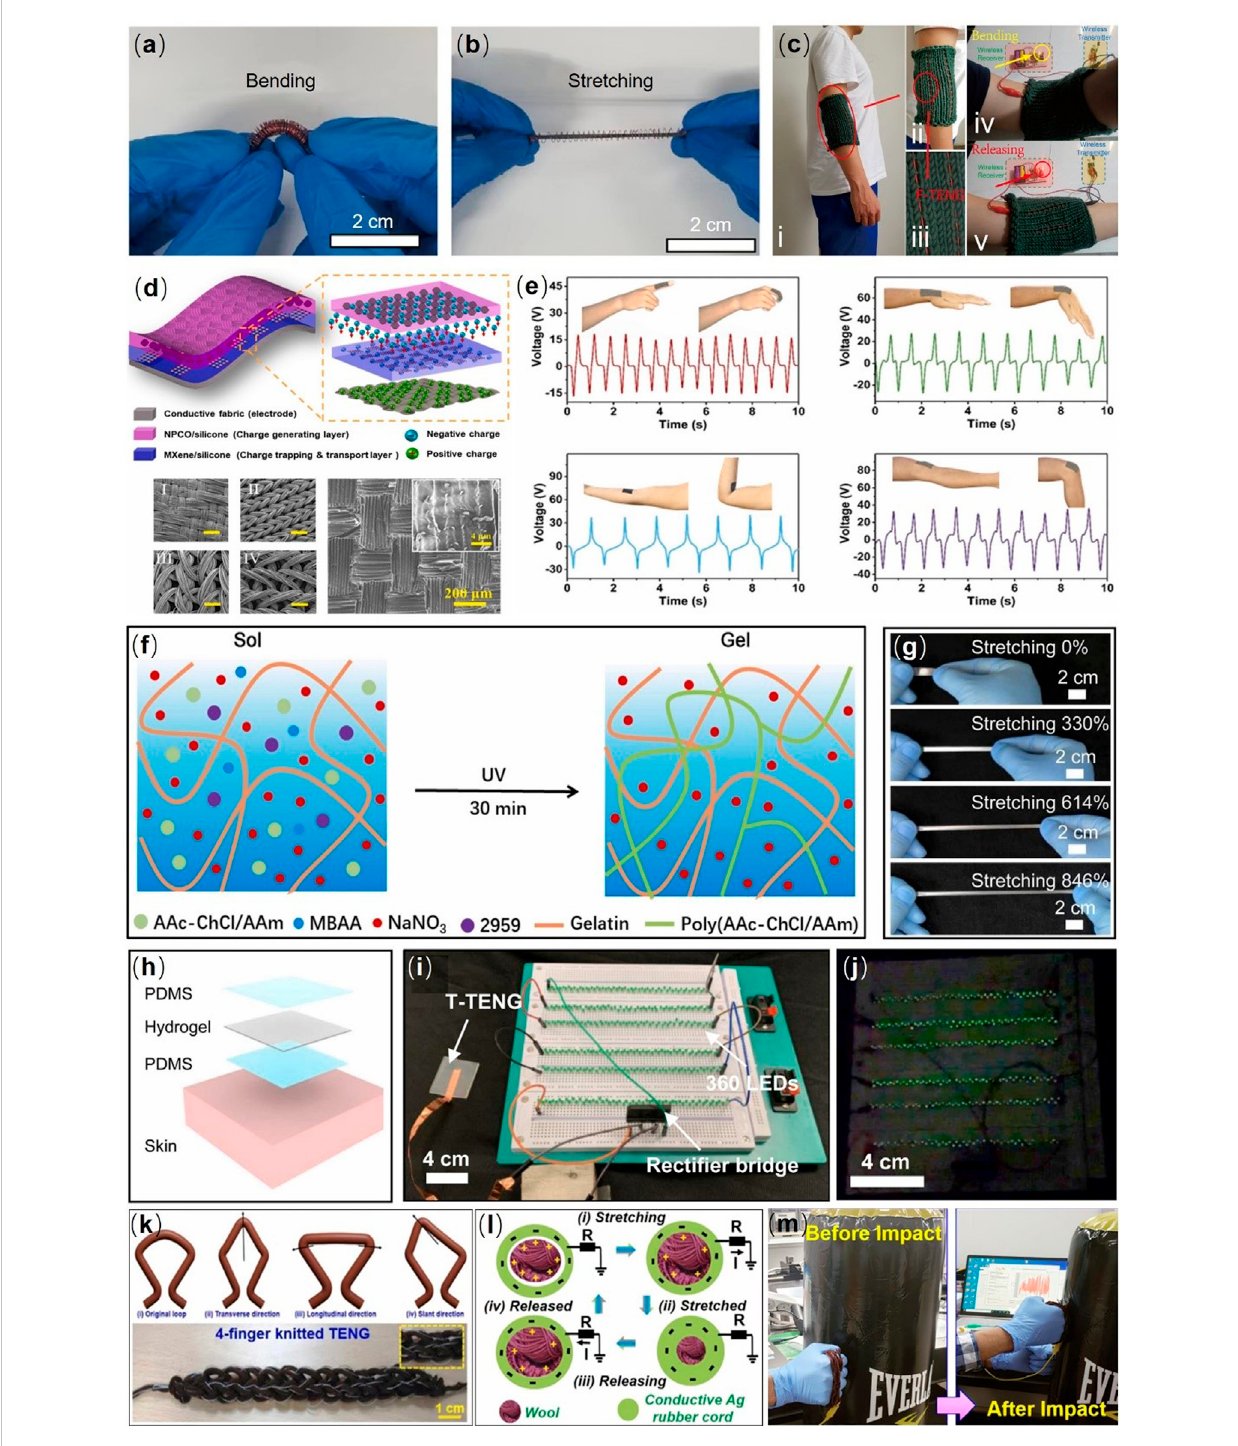
FIGURE 2 (A) F-TENG under bending. (B) F-TENG under stretching. (C) Smart clothing integrated with F-TENG (Zhao et al., 2022b). (D) Schematic description of the NDL-TENG. (E) Produced voltage signals of the self-powered biosensor integrated with NDL-TENG in response to the bending of different body joints (Rahman et al., 2022b). (F) Schematic illustration of the transparent, stretchable, and conductive hydrogel (TSCH). (G) Optical photos of the stretchabilitytesting ofTSCH. (H) Schematicillustration oftheT-TENG basedonhydrogels. (I) Opticalphoto ofthesetupfor lighting LEDsusingthe T-TENG (J) Optical photos of the 360 LEDs lit by the T-TENG (Liu et al., 2022a) (K) Deformation of the knitted textile and optical photos of the 4- fi nger knitted TENG (L) Schematic illustration of the working mechanism of the developed F-TENG (M) Optical photos of an individual imparting a punch on a boxing kit before and after impact (Sahu et al.,